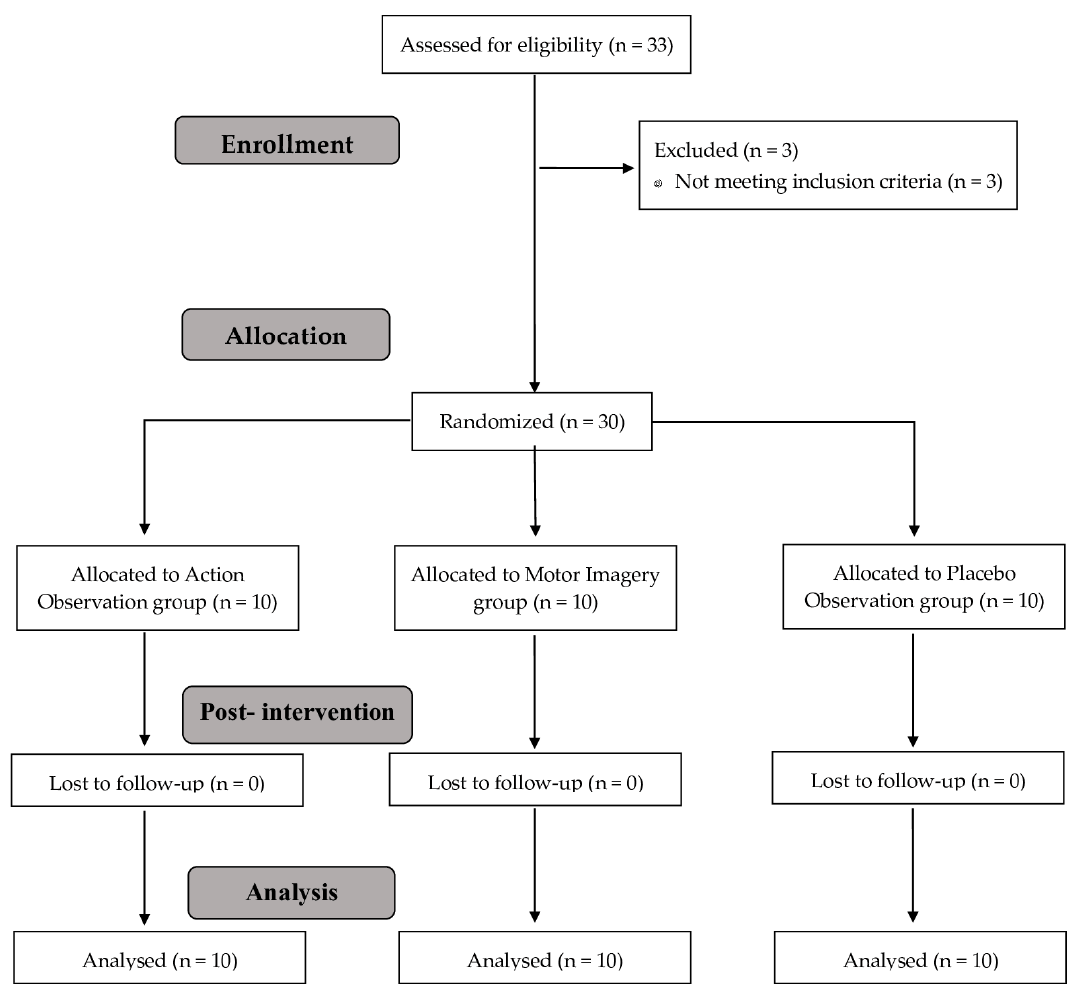
Figure 2. Study flow chart. Table 1. Descriptive statistics of sociodemographic data.